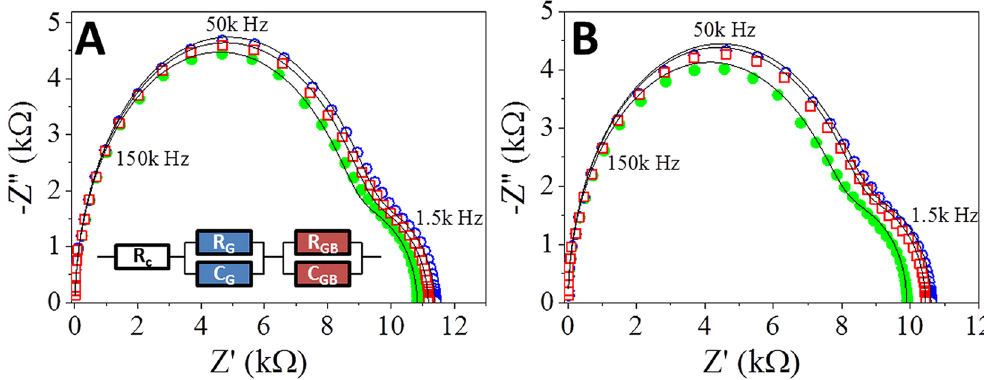
Figure 4. Impedance spectra represented as Nyquist plots of ZnO films measured during O 2 ( A ), and H 2 O ( B ) pulse experiments under UV irradiation. The solid green points were measured during the initial vacuum, open blue circles during the first pulse (1.7% O 2 ( A ) or 11.25% H 2 O), and open red squares during the recovery vacuum after the pulse. The solid lines model the data using the equivalent circuit inset. The corresponding colored arrows in Fig. 3 indicate the time at which each trace was